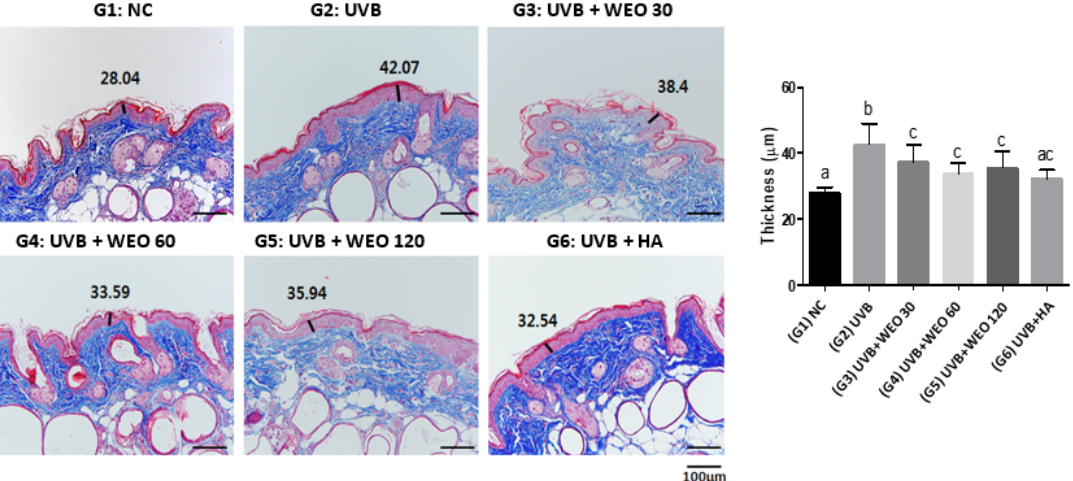
Figure 3. Epidermis thickness measurement (Masson’s trichome stain) at week 12. Values with different letters are significantly different by ANOVA followed by the Newman–Keuls multiple range test ( p < 0.05). NC: normal control, UVB: Ultraviolet, WEO: wheat extract oil, HA: Hyaluronic acid.